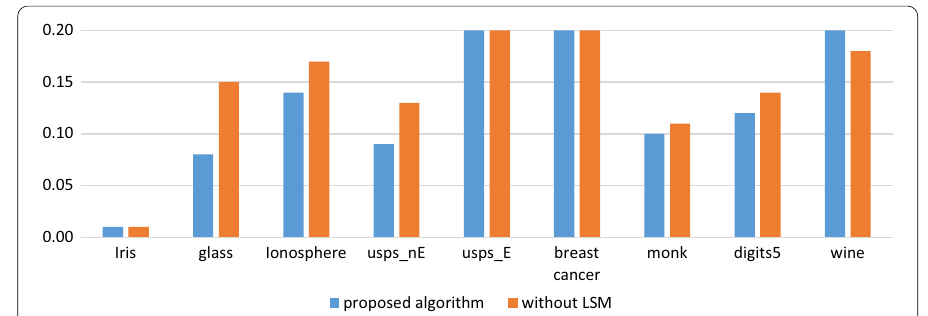
Fig. 11 The best classification runtime of proposed method with and without LSM on evaluation datasets